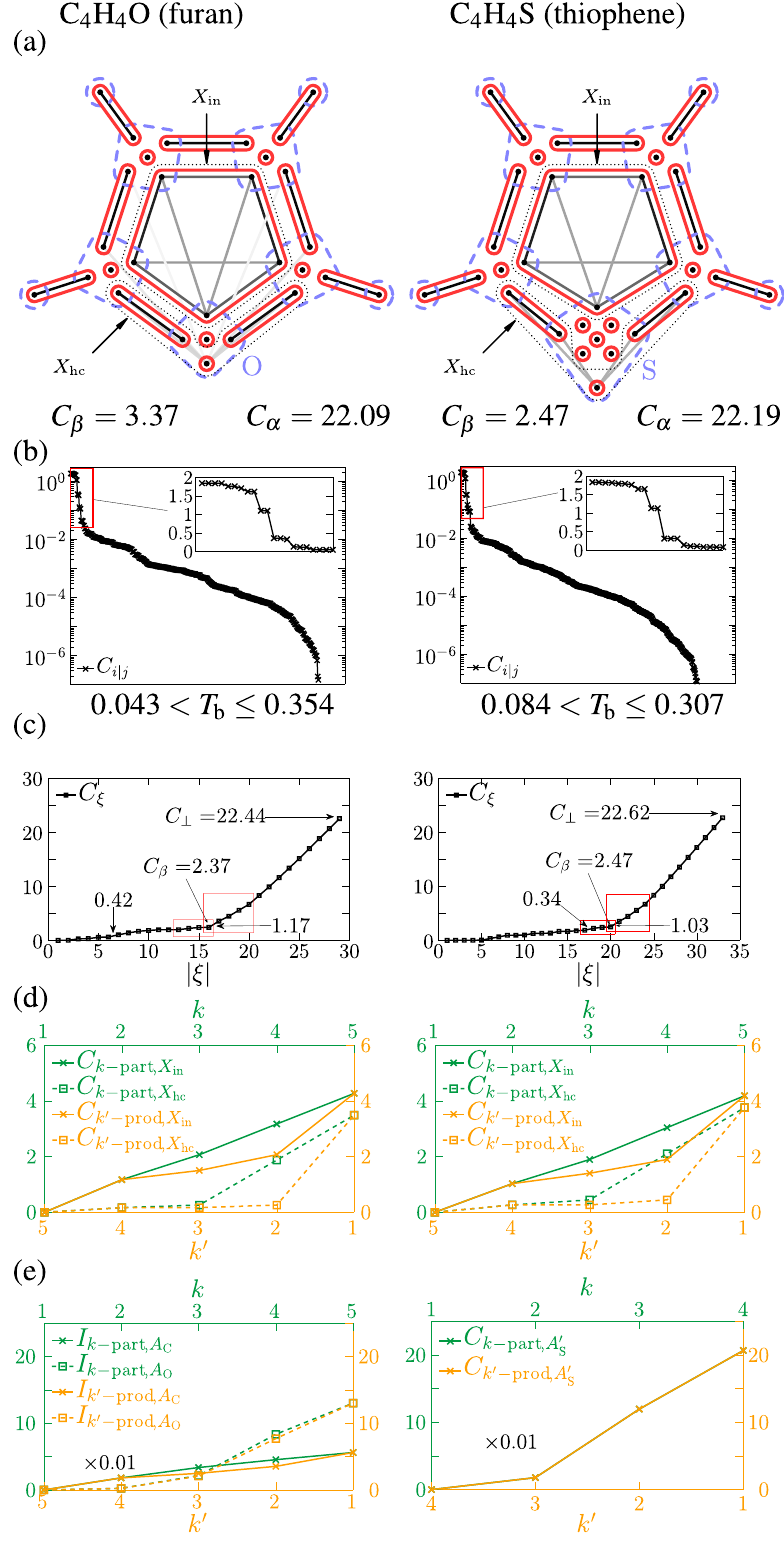
Figure 2. Partitioning and multipartite correlations for the furan and thiophene molecules. The same types of data are shown as in Fig. 1. ( d ) The correlations for the orbitals participated in the hyperconjugative interaction, contained in X hc are also shown. ( e ) For the thiophene, the correlations among the valence orbitals, contained in ′ A are S